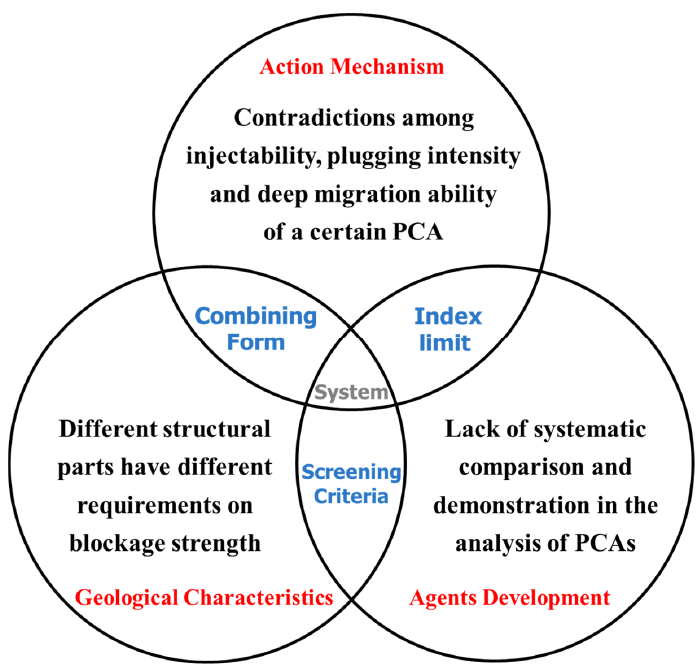
Figure 1. Understanding the compatibility of PCAs and reservoirs from three angles.